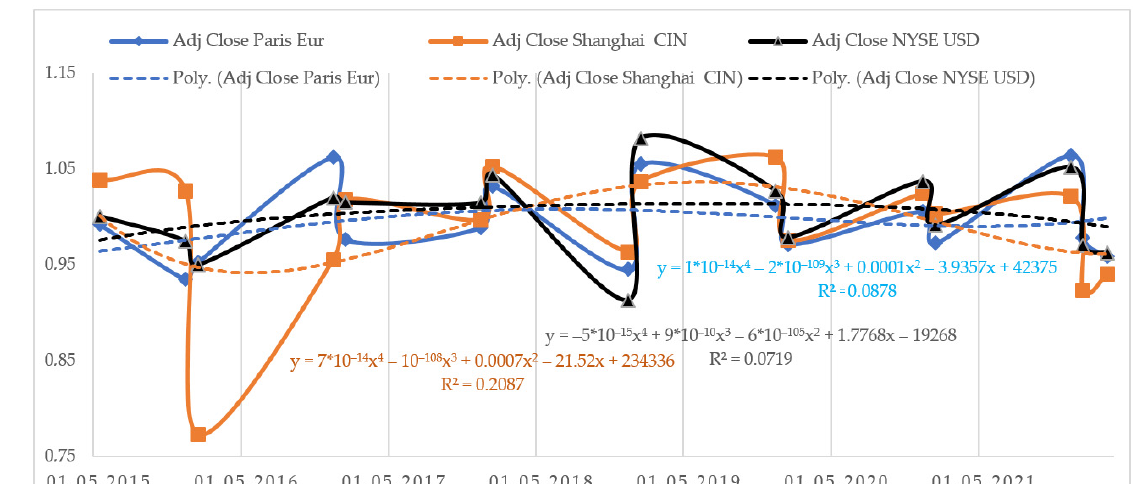
Figure 6. Analysis of the correlation of volatile indices at adjusted values, based on the model of canonical distances. Source: Authors’ calculations